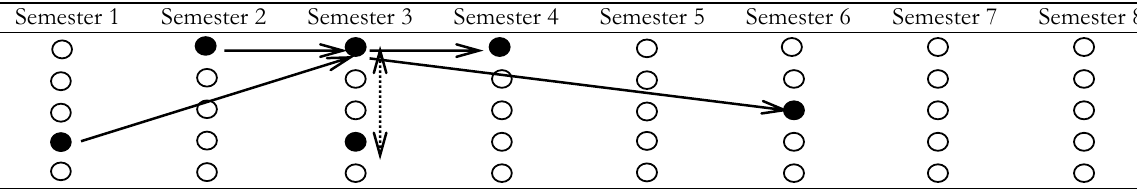
Table 2. A hypothetical example of relaxation index (RI) calculation with the node at the first course in Semester 3 (Circles represent courses, solid arrows represent pre-requisites and post-requisites, and dashed two-directional arrows represent